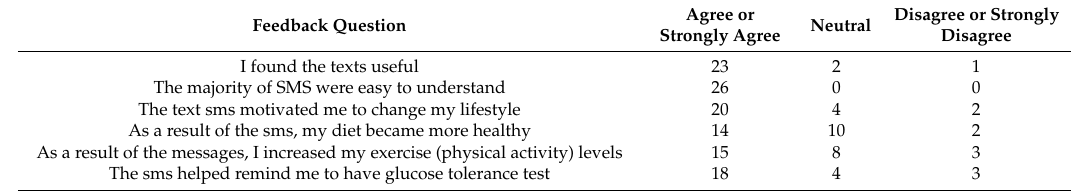
Table 3. Intervention group feedback regarding the text